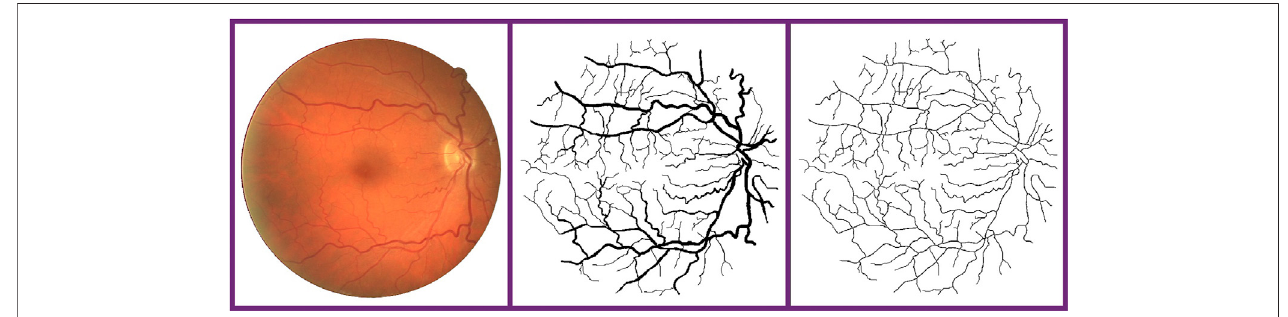
FIGURE 7 | Vessel skeleton. From the left to right: fundus retina image, ground truth, and vessel skeleton obtained by our method.